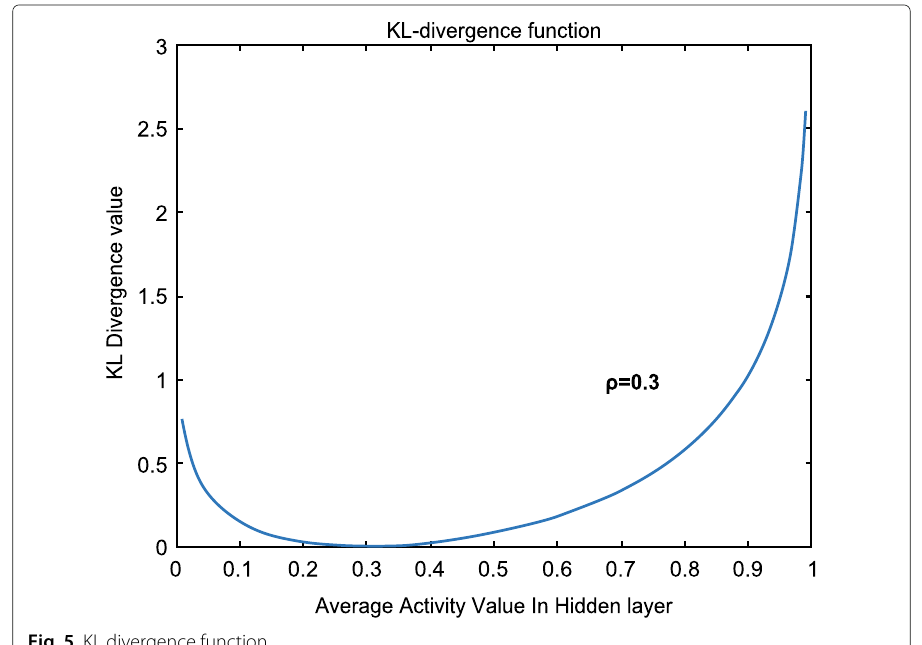
Fig. 5 KL divergence